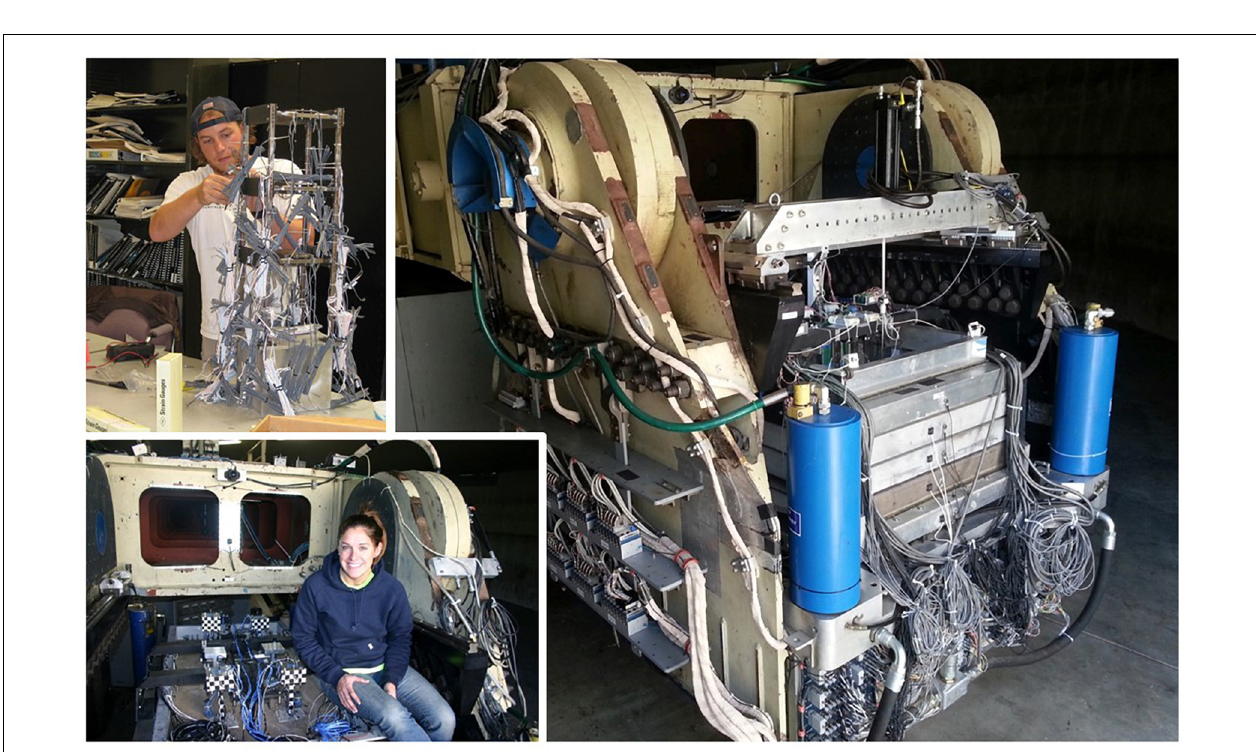
FIGURE 2 | Examples of model testing on the 9-m centrifuge: nonlinear multi-story structure-soil-structure interaction (top left insert) , multiple rocking foundation systems (lower left insert) , and in-flight cone penetration testing actuator mounted on the gantry (right) .